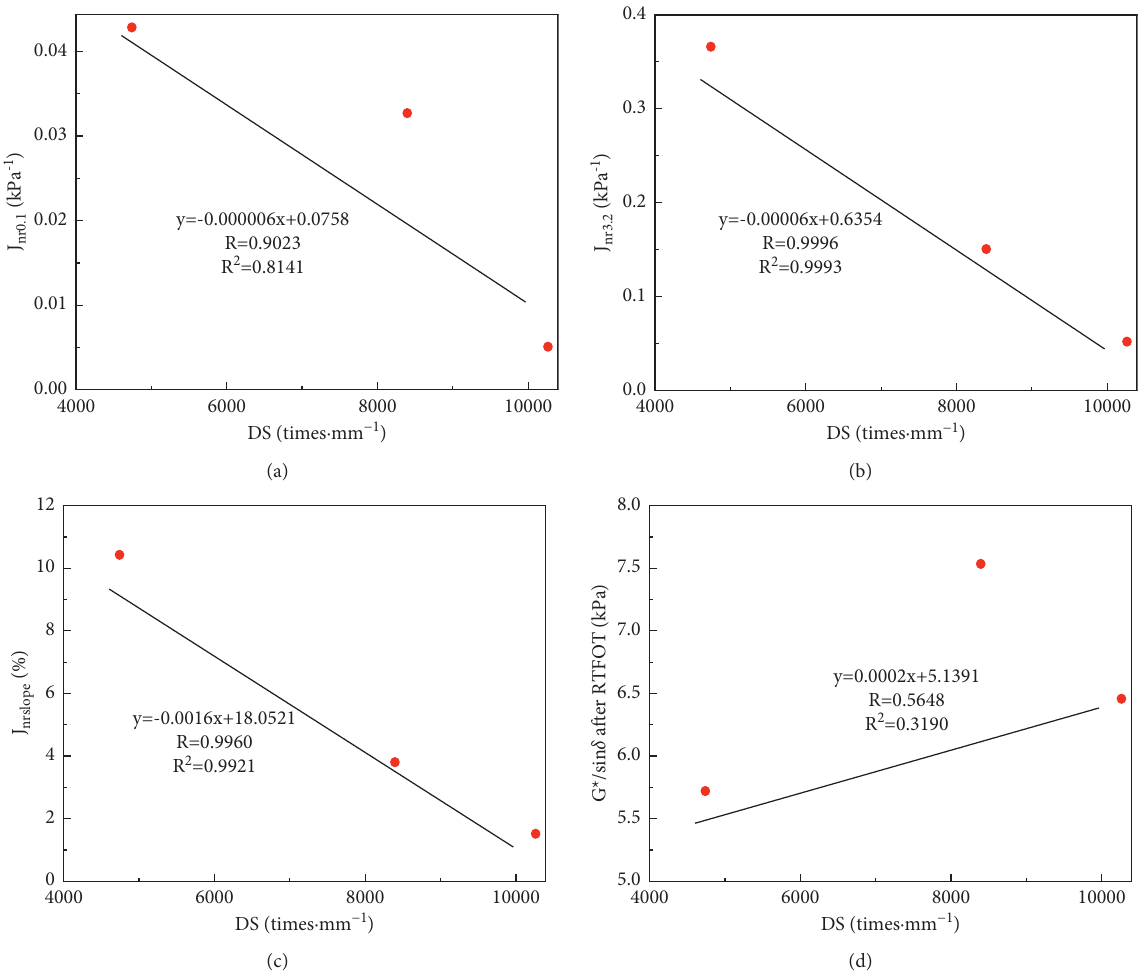
Figure 6: Correlations of DS and (a) J nr0.1 of modified asphalt. (b) J nr3.2 of modified asphalt. (c) J nrslope of modified asphalt. (d) RTFOT of modified